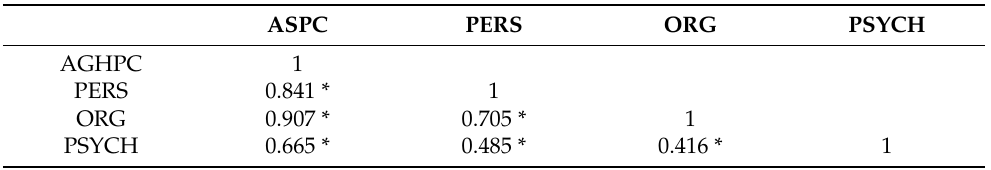
Table 3. Spearman’s correlation coefficients (rho) between total score of the Adherence to Good Hospital Practices for COVID-19 and its domains ( n = 307).